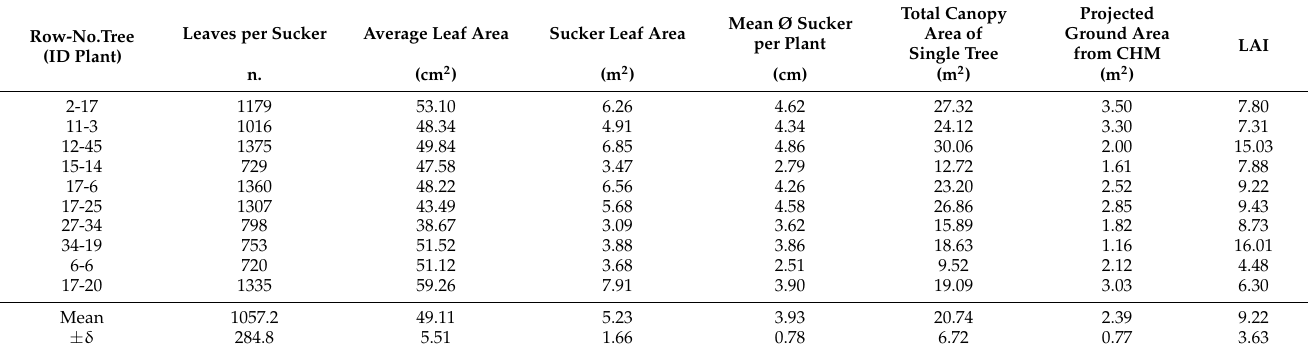
Table 1. Estimated values of Leaf Area Index from circumference measurements and leaf area of individual